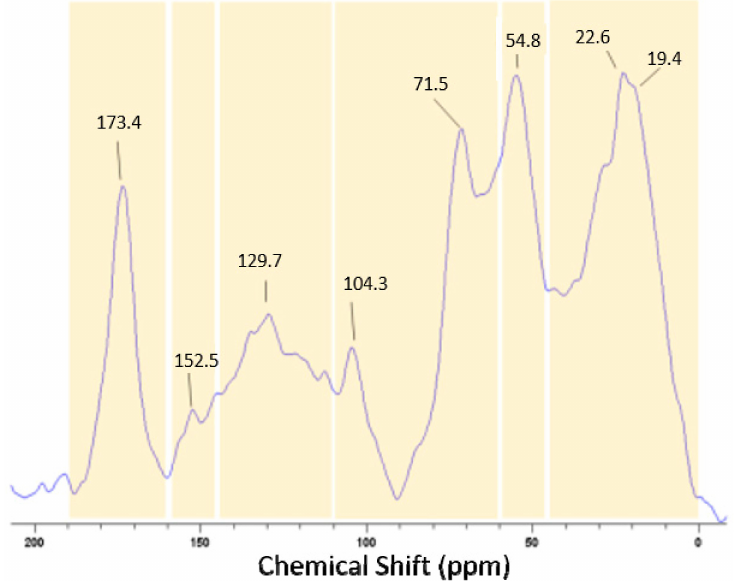
Figure 2. 13 C-CPMAS-NMR spectrum of green ground coffee compost; the numbers above the peaks represent the chemical shift signals assigned to the main organic functional groups: 0–45 ppm (aliphatic C), 45–60 ppm (O-substituted alkyl C), 60–110 ppm (O-alkyl C), 110–145 ppm (aromatic C),